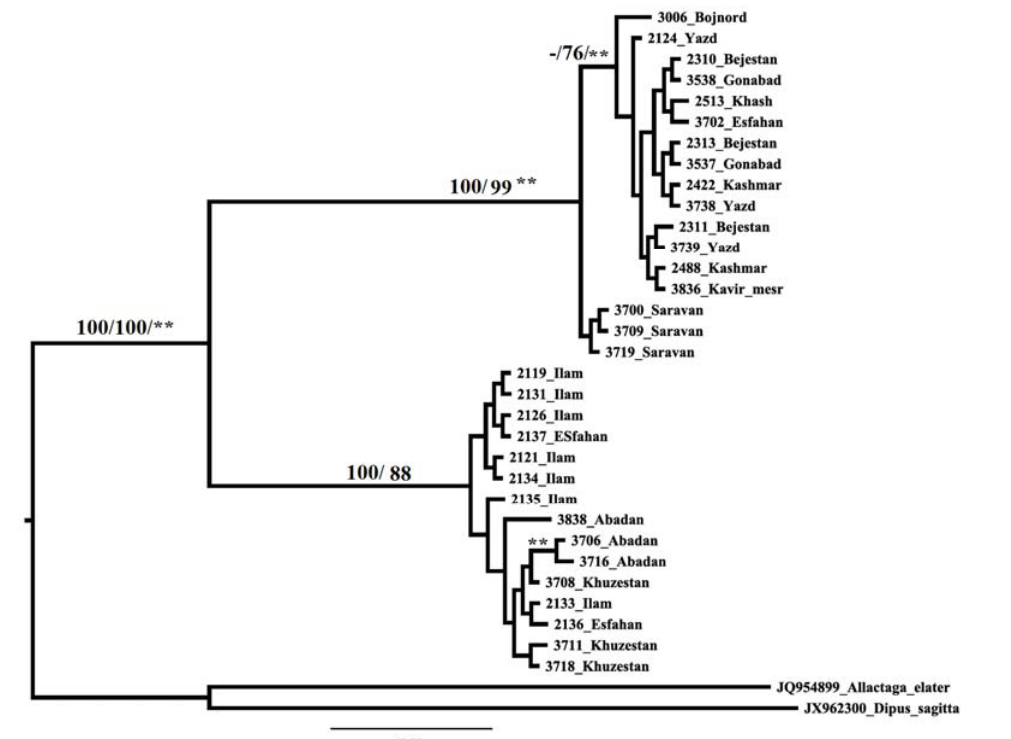
F IGURE 11. Ninety-percent majority-rule consensus tree sampled from the posterior distribution of the most-partitioned analysis. Posterior probability values from the Bayesian analysis are indicated at the >99% (**) >95% (*) significance levels. Numbers represent ML and MPbootstrap values (500/5000 replicates; given only if>50%).